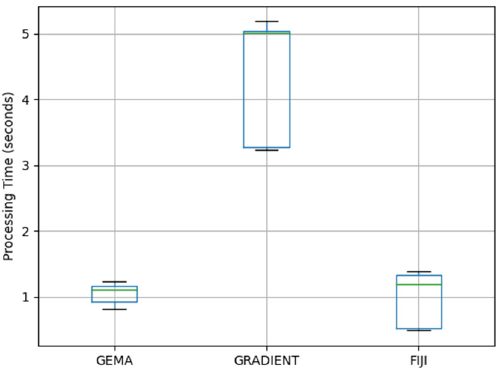
Figure 12. The box plots of the processing time used by each method during the segmentation process in two datasets.